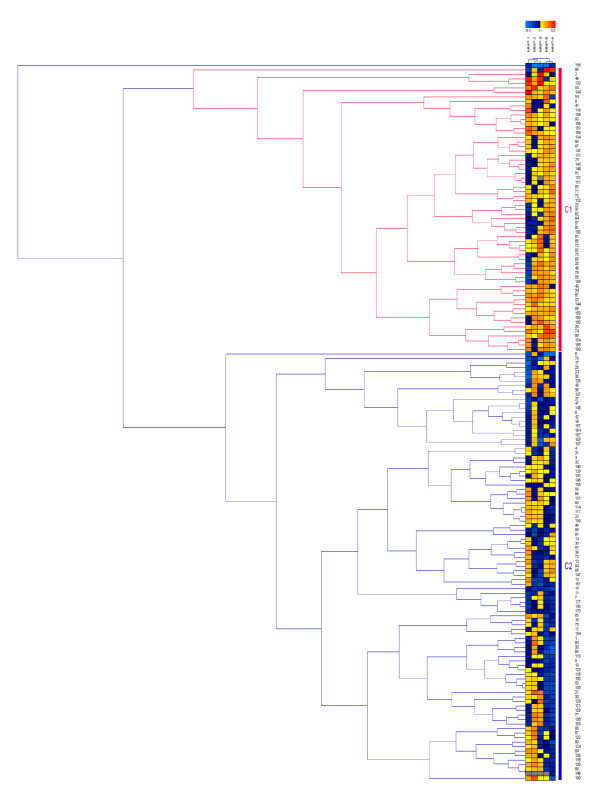
Hierarchical cluster analysis of serum matrix metalloproteinase levels in patients with ankylosing spondylitis. Results are displayed as a heat map and dendrogram in which the relative levels of matrix metalloproteinases (MMPs) are represented by shades of yellow/red (high) and blue (low). Each row represents the MMP profile for an individual patient, each of which is represented by a number on the vertical axis. Each column represents a different MMP (MMP-1, MMP-2, MMP-3, MMP-8 and MMP-9, left to right). C1, high MMP cluster; C2, low MMP cluster.